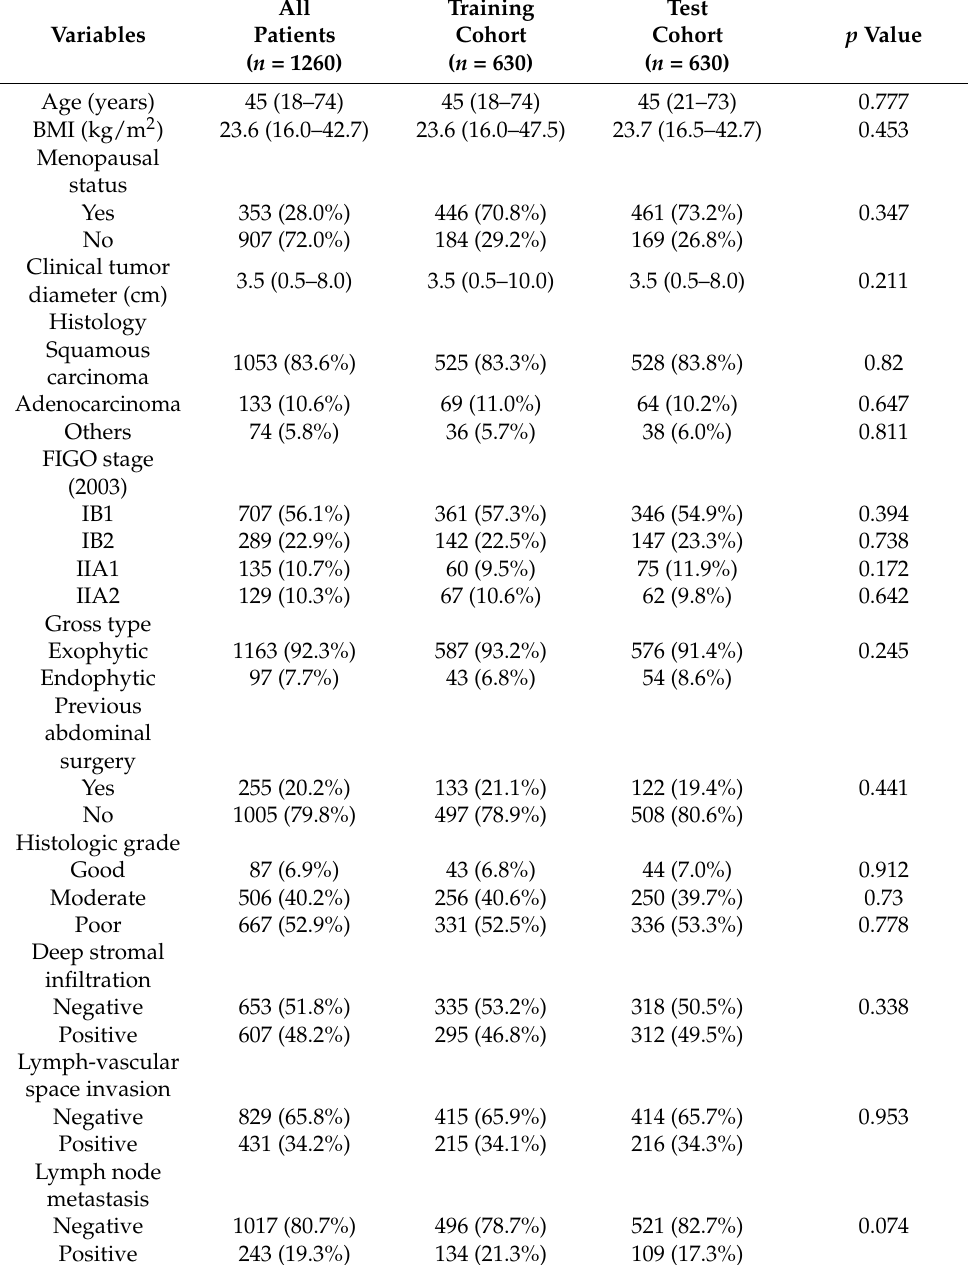
Table 1. Clinical and pathologic characteristics of 1260 patients with cervical